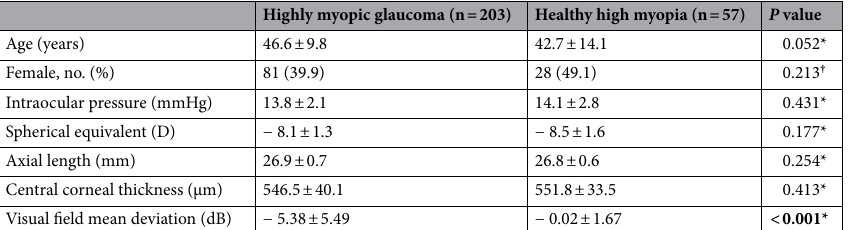
Table 1. Comparison of demographics and clinical characteristics between highly myopic glaucomatous eyes and healthy highly myopic eyes. Data are mean ± standard deviation unless otherwise indicated. Boldface indicates P < 0.05. *Student’s t -test. † Chi-square test.